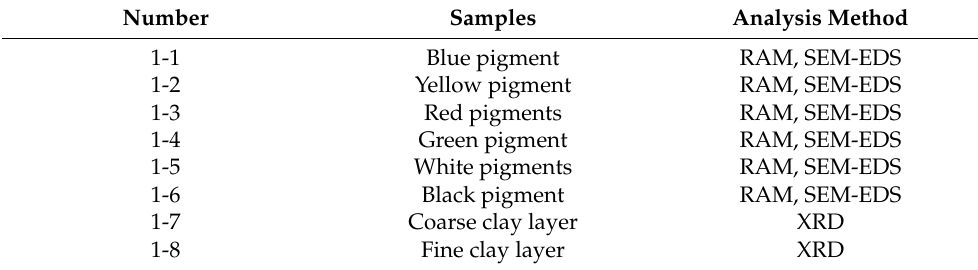
Table 1. Sampling information for the polychrome